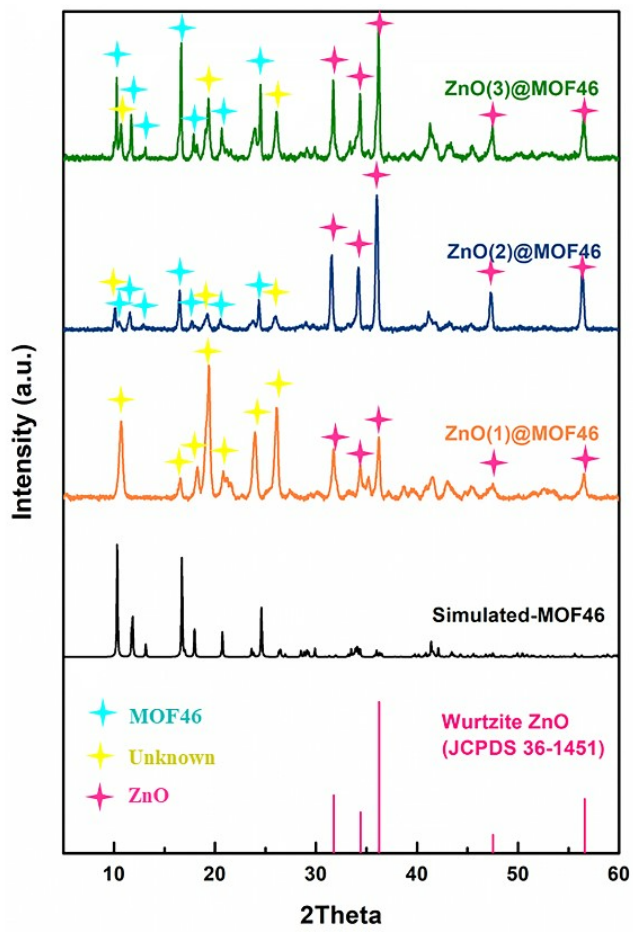
Figure 5. XRD patterns of ZnO@MOF-46(Zn) products from all prepared ZnO. The cuboctahedral and octahedral ZnO morphologies comprise several {111} facets.